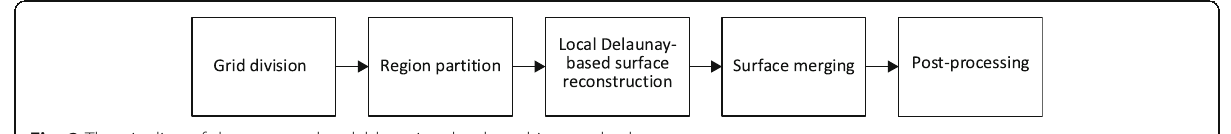
Fig. 2 The pipeline of the proposed scalable point-cloud-meshing